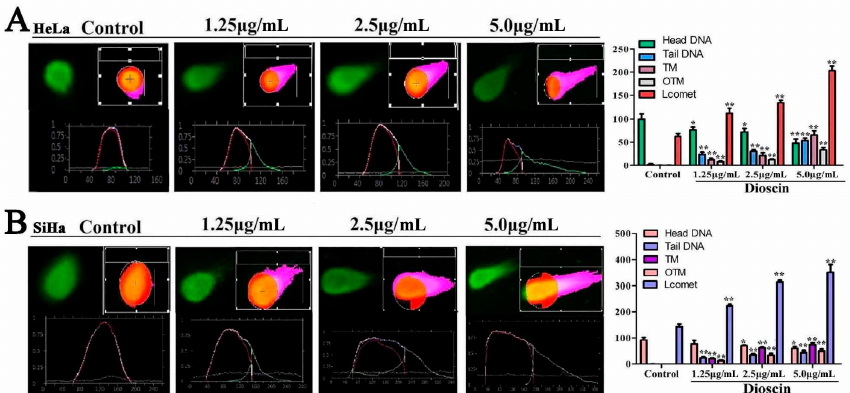
Figure 8. Dioscin induced HeLa and SiHa cell apoptosis. ( A ) Dioscin caused apoptosis in HeLa cells by flow cytometric analysis with Annexin V-FITC and PI-staining; ( B ) Dioscin caused apoptosis in SiHa cells by flow cytometric analysis with Annexin V-FITC and PI-staining. Data are presented as mean ± SD ( n = 3). * p < 0.05 and ** p < 0.01 compared with control group.